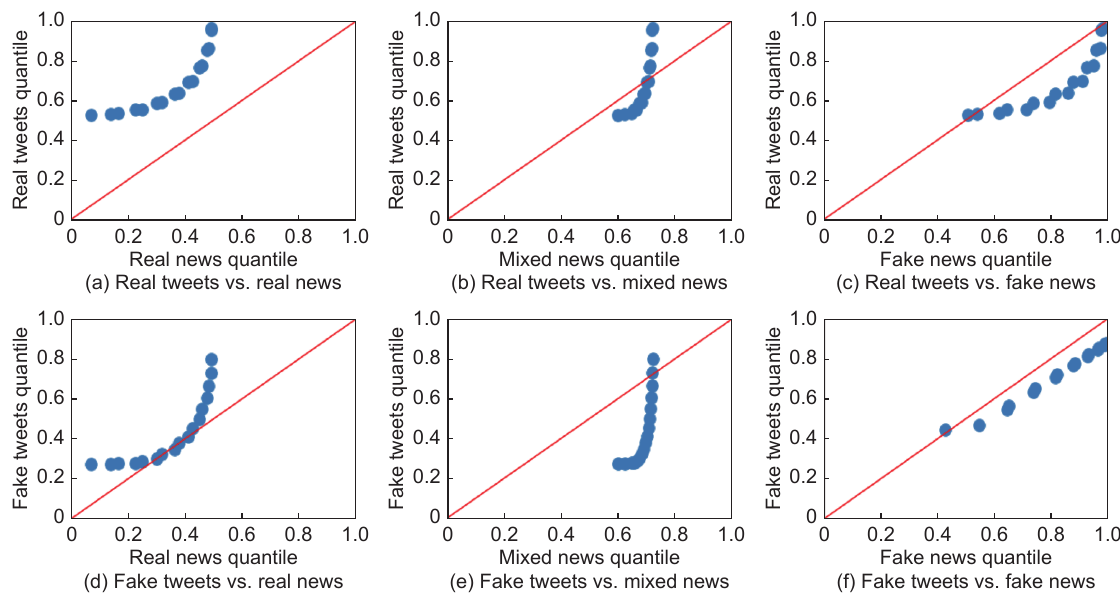
Fig. 10 Quantile-Quantile (Q-Q)-plot of news and tweets used to measure community resilience where x-axis refers to the quantiles of real, mixed, or fake news and y-axis indicates the quantiles of real or fake